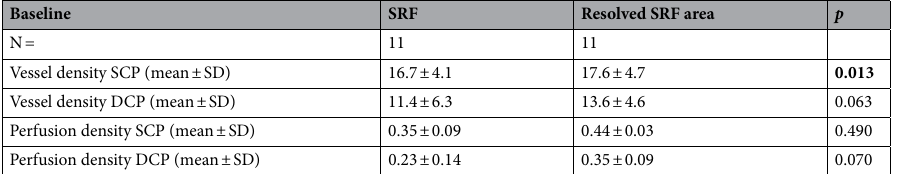
Table 2. Vessel and perfusion density analysis for subretinal fluid and areas with resolved SRF at month one. Stastistically signficant p values are marked in bold. SRF subretinal fluid, mm millimetre, SCP superficial capillary plexus, DCP deep capillary plexus, SD standard